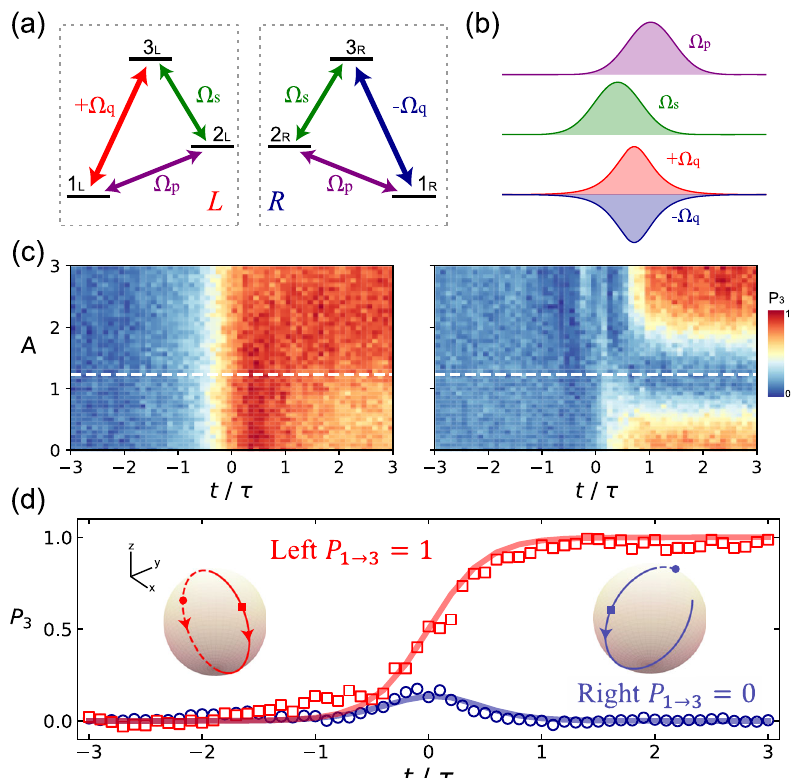
Fig. 3 Chiral separation via CCI. a Coupling schemes of chiral molecules with L and R handedness. Identical drivings result in a difference of π in the overall phase of the loop, indicated here as different couplings (± Ω q ) between the states of 1 and 3. b Pulse sequence for the driving fi elds Ω p ( t ), Ω s ( t ), and ± Ω q ( t ). c Measured population P 3 versus time and pulse area A π for L (left panel) and R (right panel) handedness, where the initial state ψ 0 j i ¼ 1 j i . The maximum population contrast is obtained when A ≈ 1.23 (indicated by the white dashed lines). t = 0 corresponds to the moment when the ± Ω q pulse reaches its maximum magnitude. d The population P 3 as a function of time for A = 1.23, showing that the transfer to the state of three is nearly perfect for L handedness, but completely suppressed for R handedness. The spheres illustrate the trajectories of state evolution in the Majorana representation by mapping the qutrit states to two points on the spheres 42 (see Supplementary Note